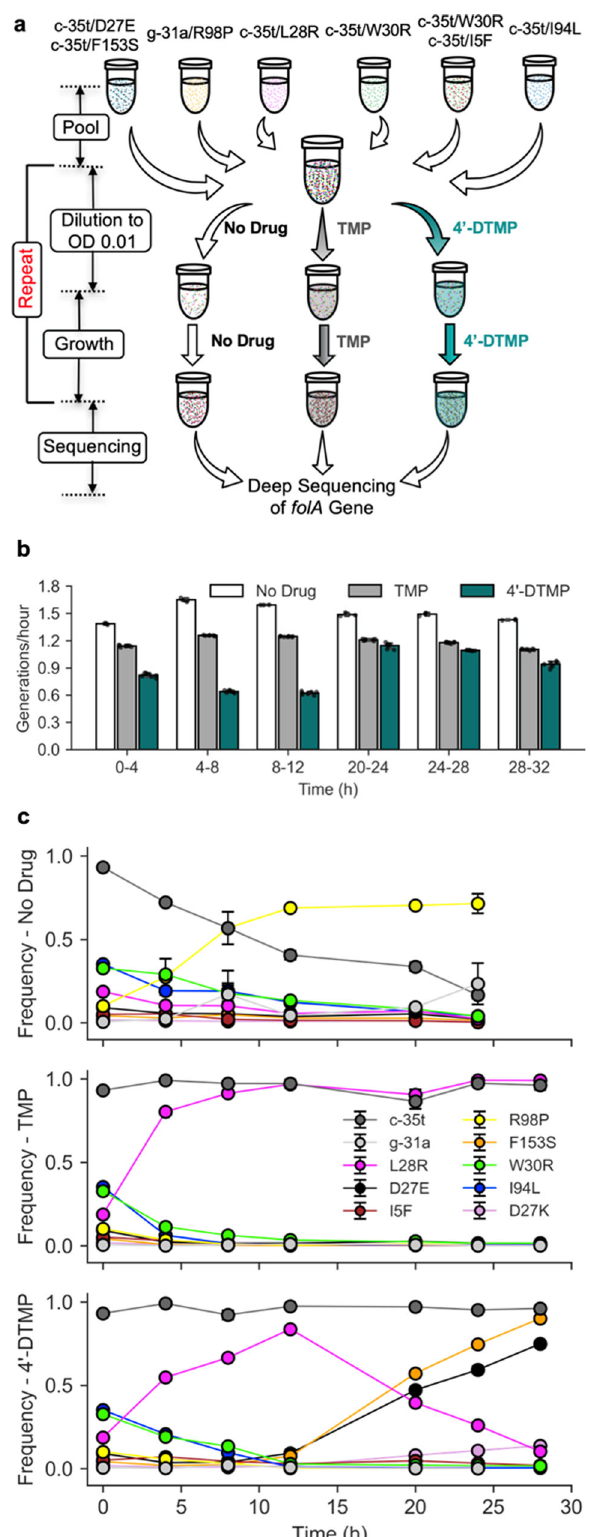
TMP and 4 ′ -DTMP select for cross-resistance to one another. However, bacterial populations evolved under 4 ′ -DTMP selection grow slower and have signi fi cantly longer doubling times com- pared to the populations evolved under TMP (Supplementary Table 3, 63.7 ± 12.5 min and 49.8 ± 10 min, respectively; Student ’ s t -test, p = 0.04). In summary, long-term evolution of E. coli under